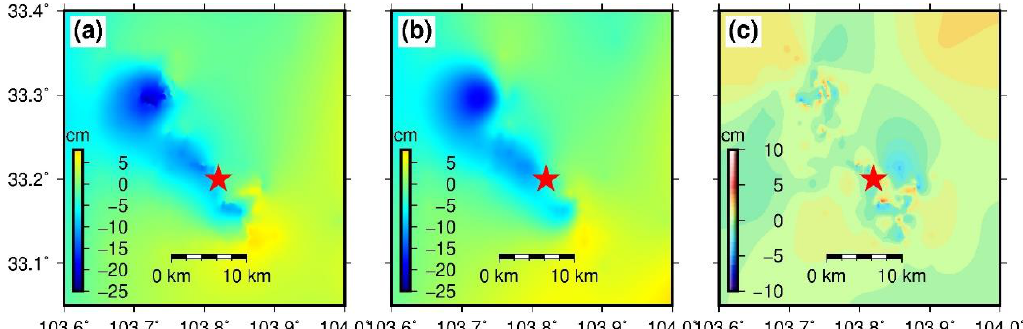
Figure 6. Comparison between InSAR observations and predictions from our preferred model. ( a ) Coseismic LOS deformation. ( b ) Simulated LOS deformation. ( c ) Residuals. Other symbols are the same as Figure 3.